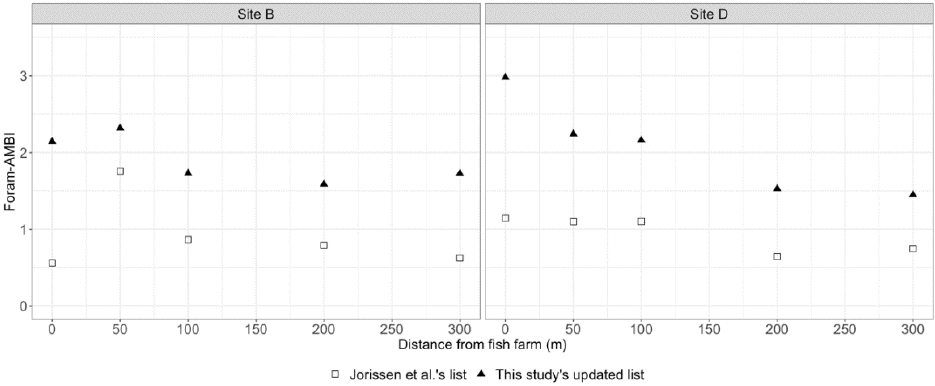
Figure 10. Comparison of Foram-AMBI values according to [47] and the study-updated list.